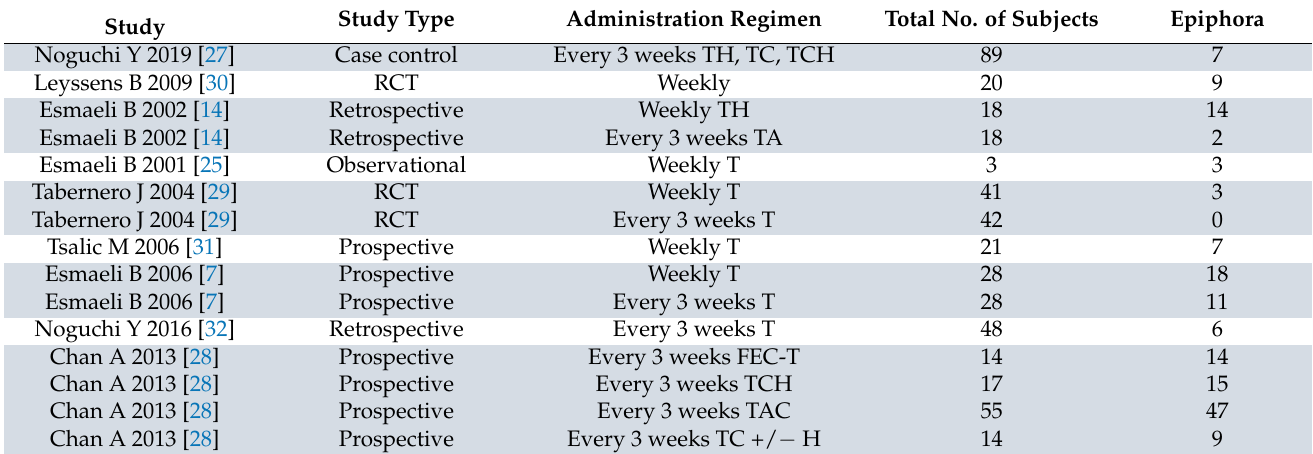
Table 1. The selected clinical trials and the specific chemotherapeutic regimens.